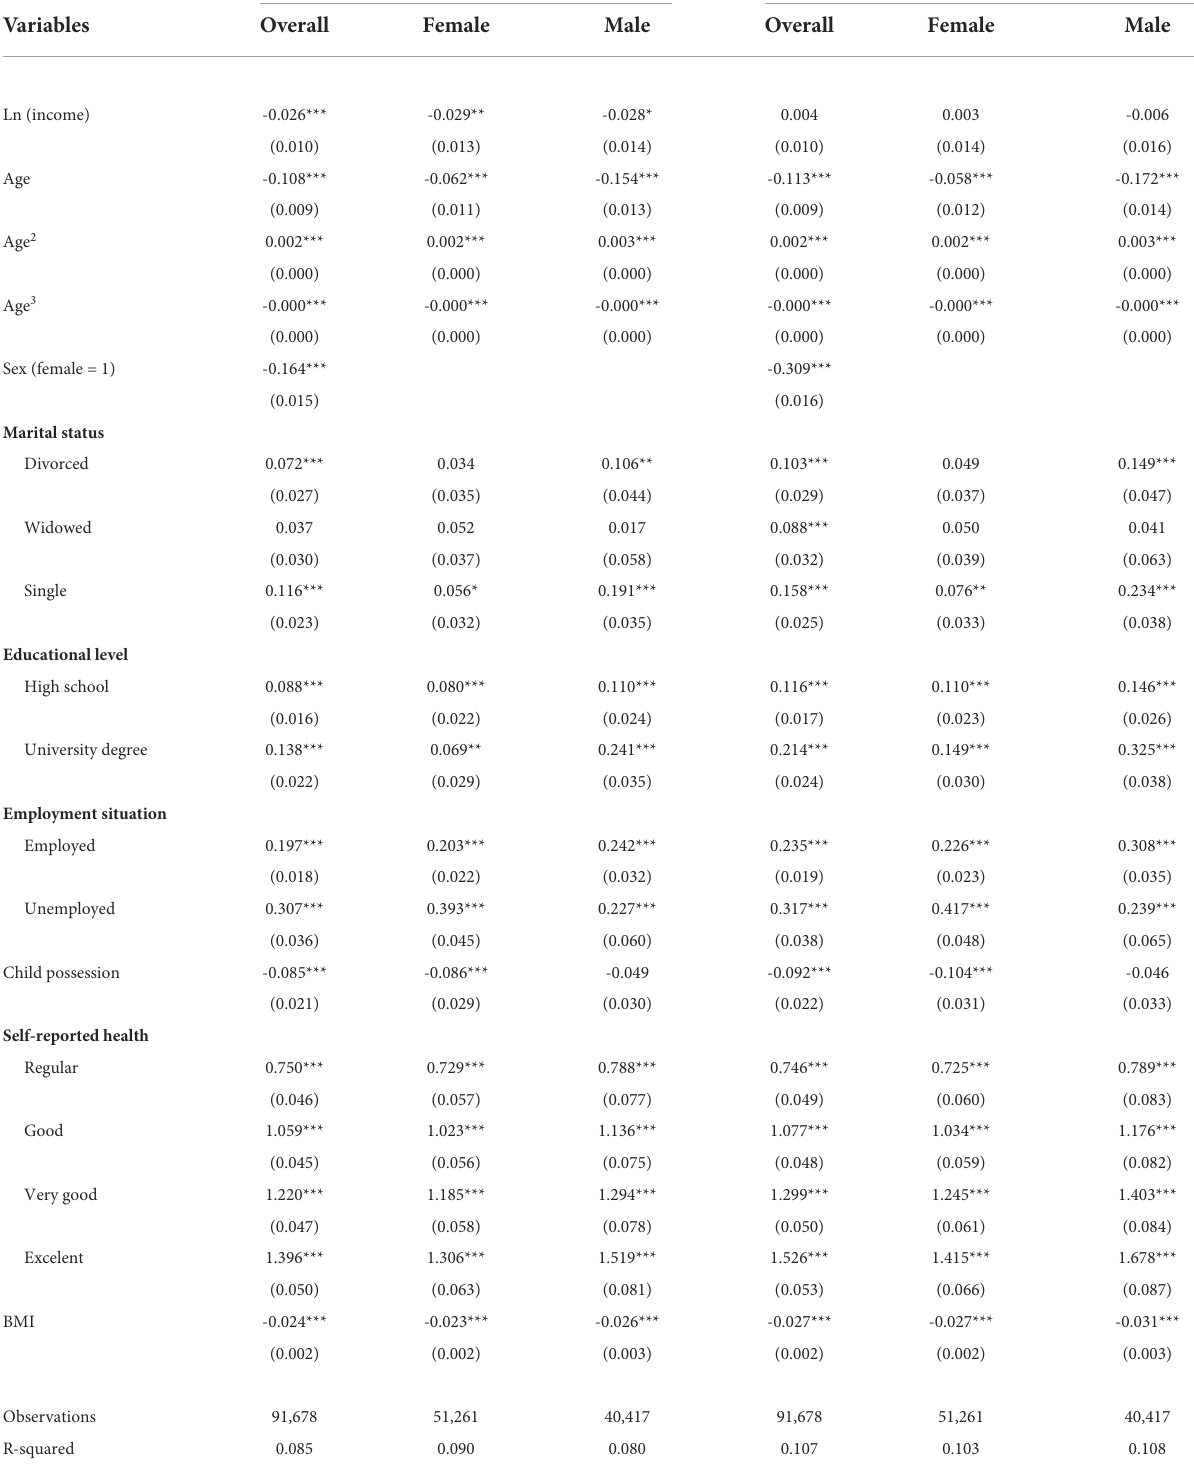
TABLE 2 Estimation by ordinary least